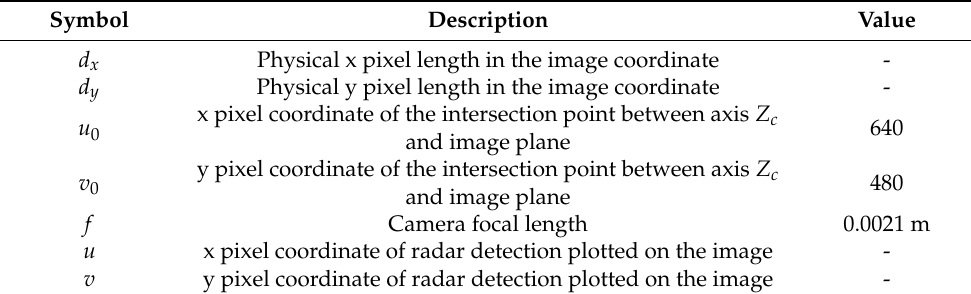
Table 1. Parameters to find the transformed coordinate ( u , v ).